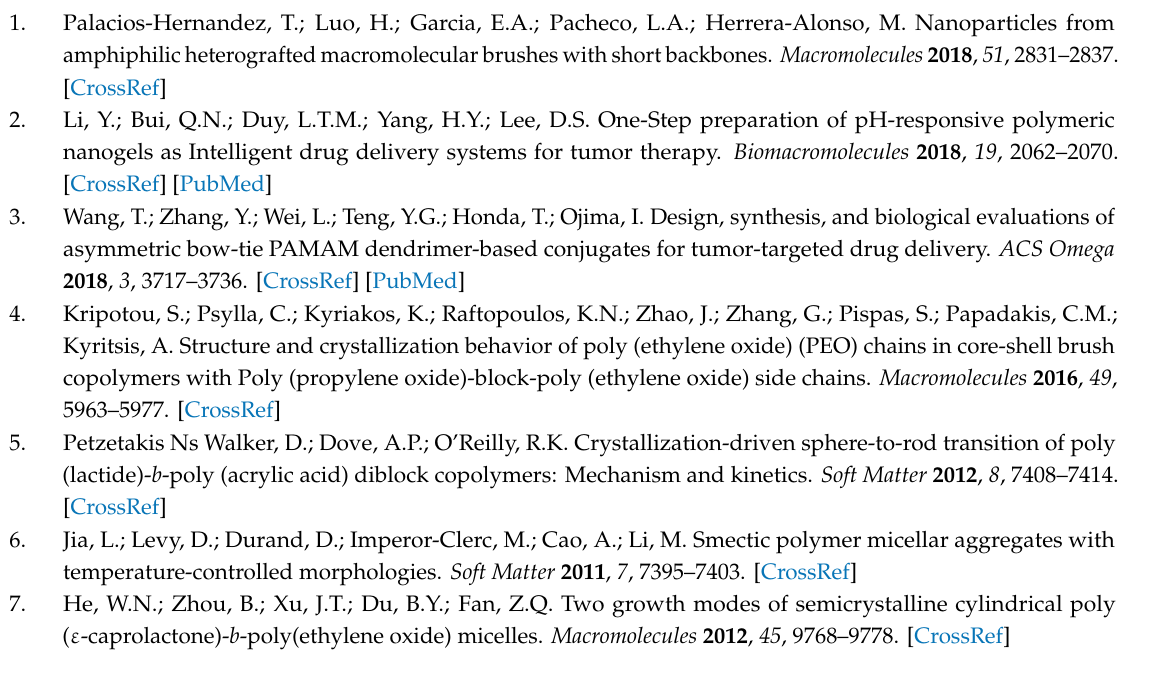
Figure S1: SEM images of 0.01 g L − 1 PEG-acrylic rosin polymer at ( a ) 25 ◦ C, ( b ) 85 ◦ C and ( c ) 5 ◦ C respectively. Author Contributions: Y.Z. conceived and designed the experiments; M.Z. and H.L. performed the experiments; F.D., F.L. and X.T. analyzed the data; J.Z. (Jinyan Zhang) contributed analysis tools; Y.Z., Q.H. and J.Z. (Juying Zhou) wrote the